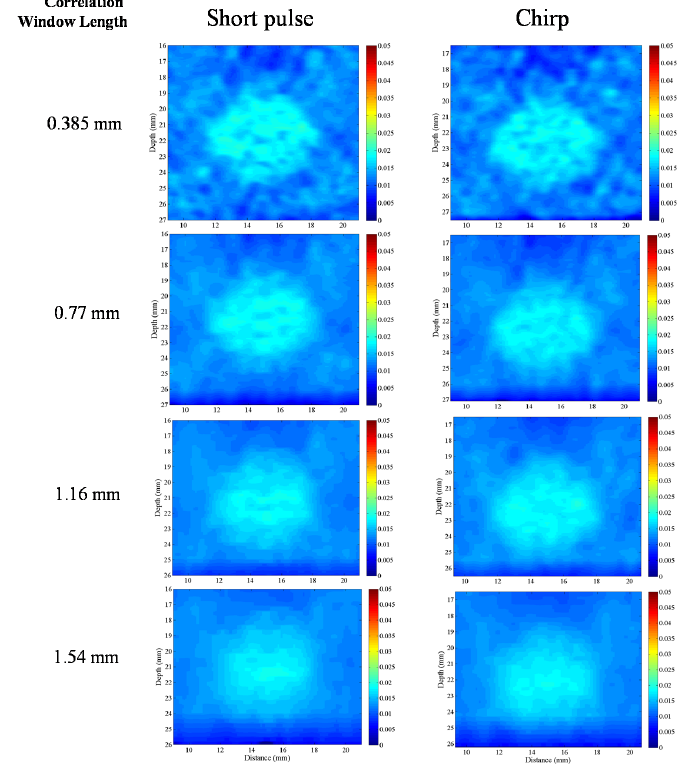
Figure 23. Strain imaging with different correlation window length. The correlation windows are 0.38, 0.77, 1.16 and 1.54 mm from top to bottom.